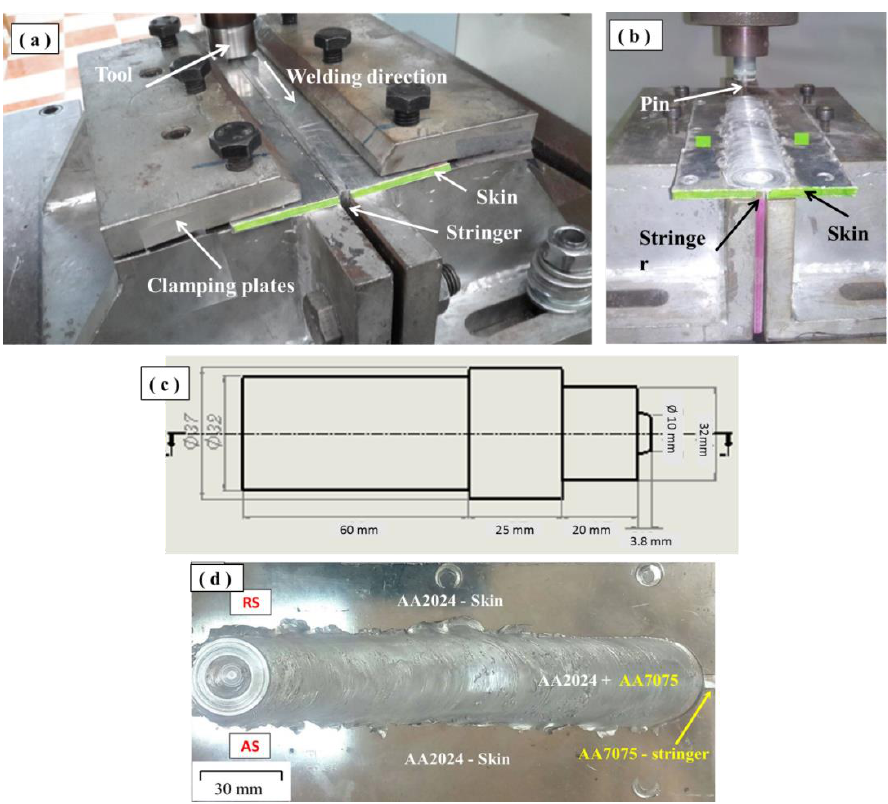
Figure 1. ( a , b ) FSW fixture setup configuration of AA2024 and AA7075 T-butt joint, ( c ) Engineering drawing of the used tool ( d ) top view appearance of a friction stir welded joint. drawing of the used tool ( d ) top view appearance of a friction stir welded